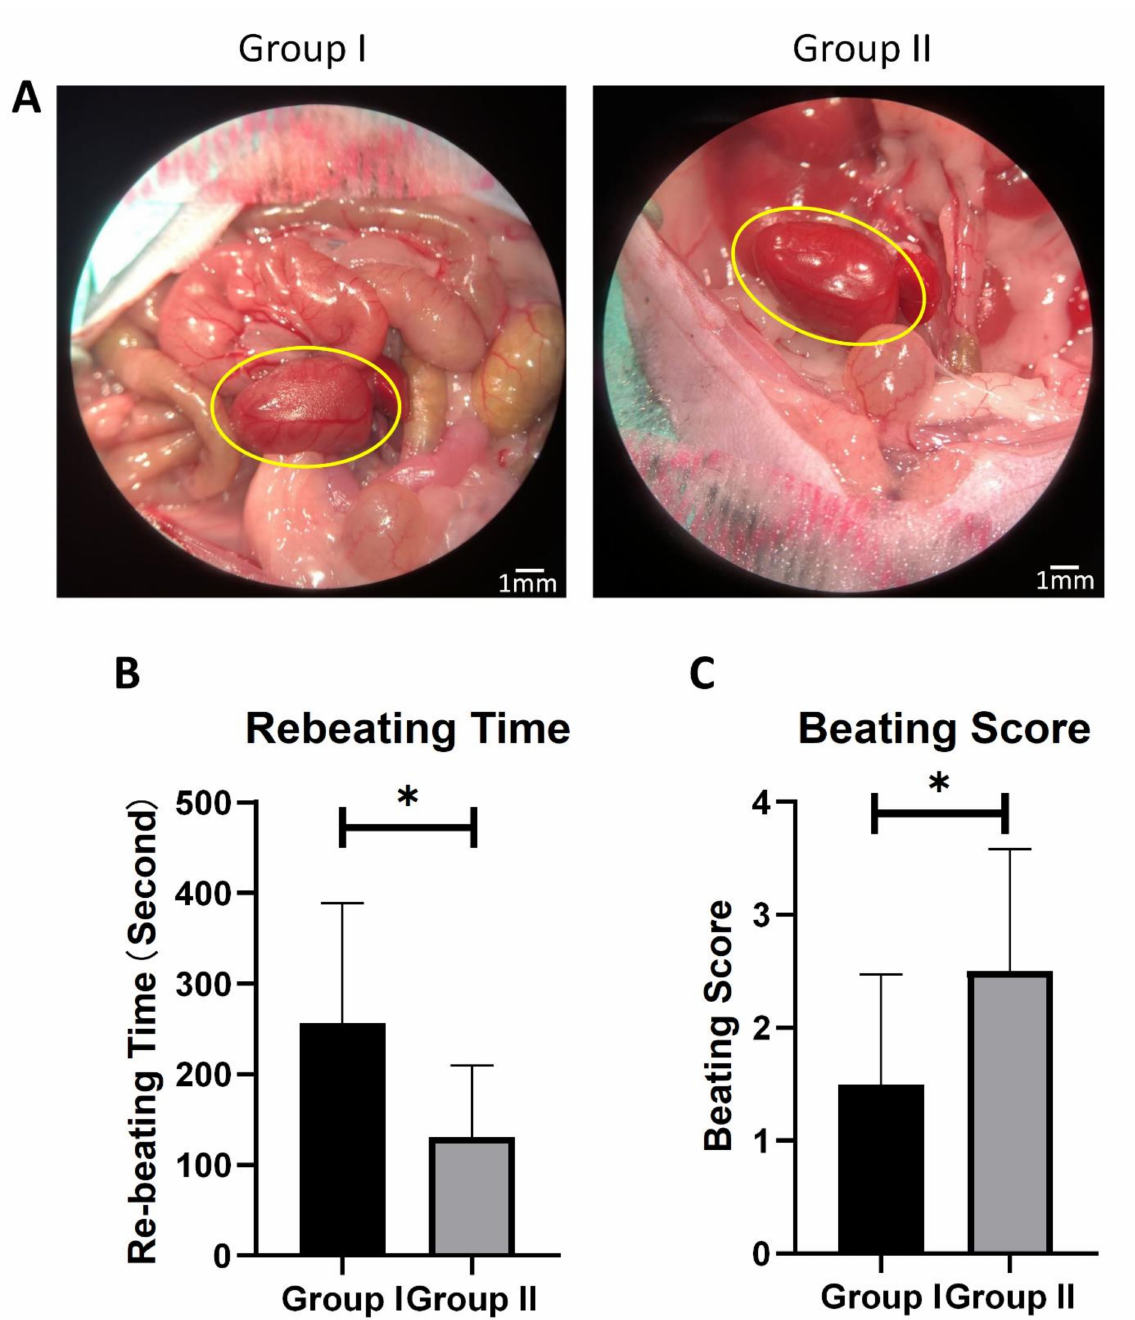
Figure 4. Graft functional recovery from 6 h cold ischemia in two groups. ( A ) Representative reperfusion photographic images of two groups after 6 h preservation. Scare bar indicates 1 mm. ( B ) Donor heart rebeating time during reperfusion. ( C ) Beating score measured by the Stanford cardiac surgery laboratory graft scoring system. n = 10, * p <